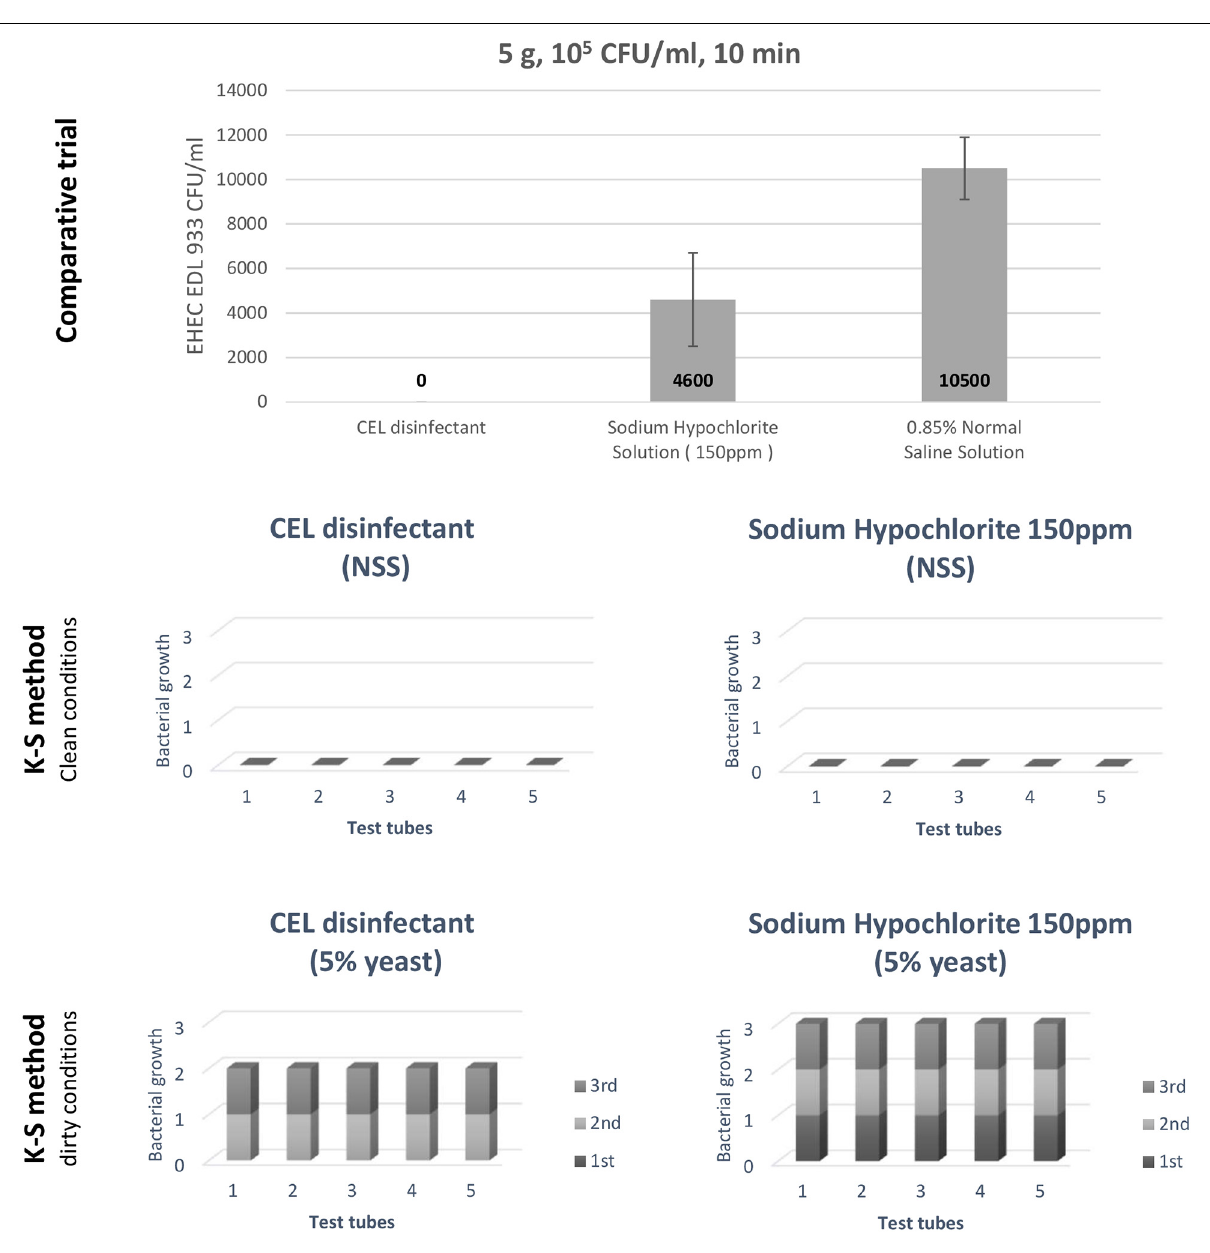
Frontiers in Microbiology |